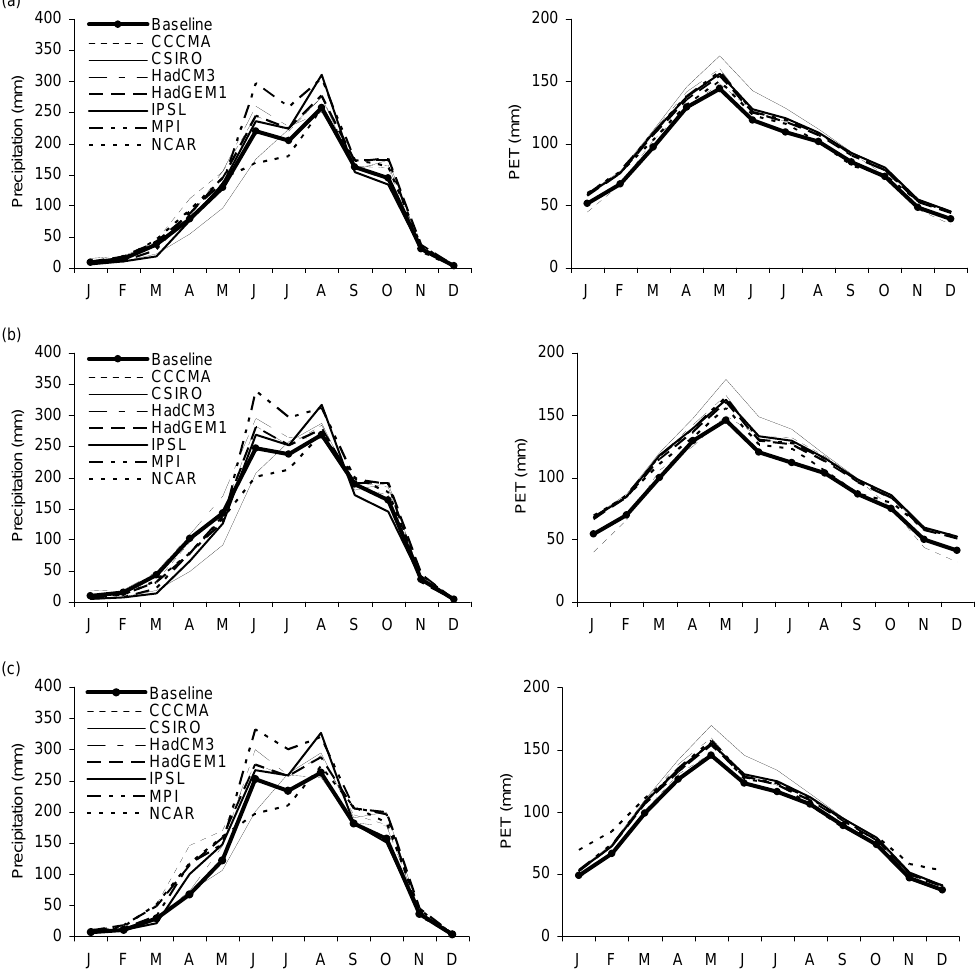
Fig. 4. Precipitation and PET in modelled sub-catchments for the Group 1 scenarios (a) Thoubal, (b) Iril, (c) Nambul (note different y-axis scales for precipitation and